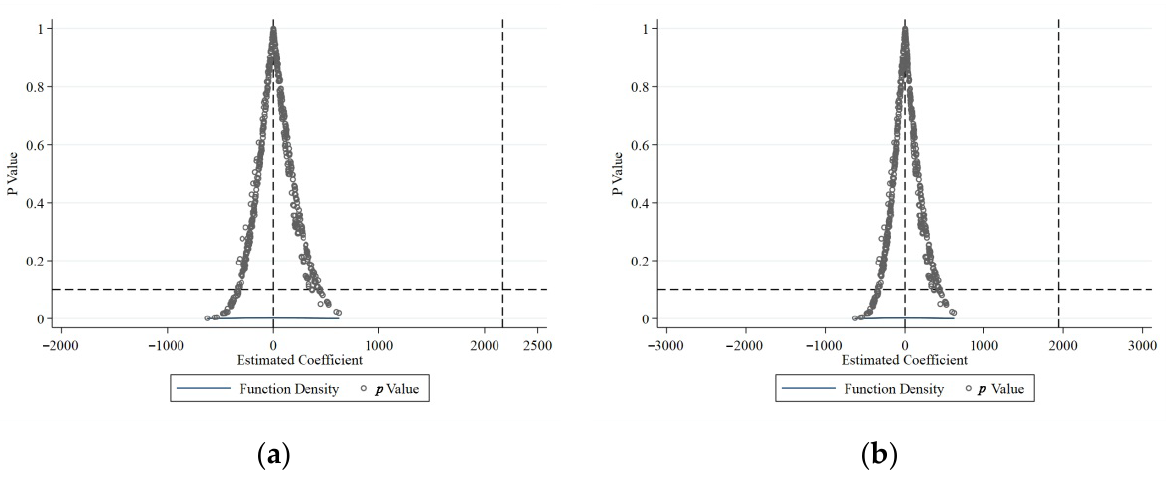
Figure 4. Placebo test results. ( a ) Samples in Tanglang Village Committee of Tanglang Township; ( b ) Samples in Dache Village Committee of Zehei Township.